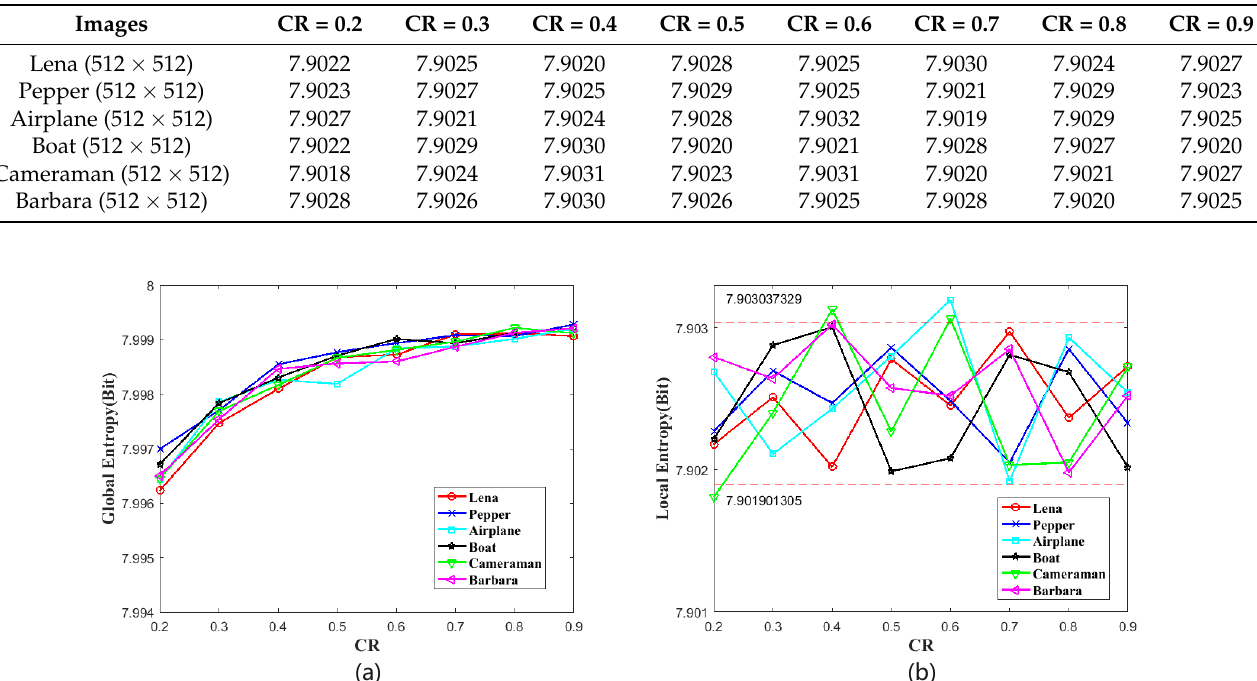
Figure 10. The information entropy analysis. ( a ) is global entropy. ( b ) is local